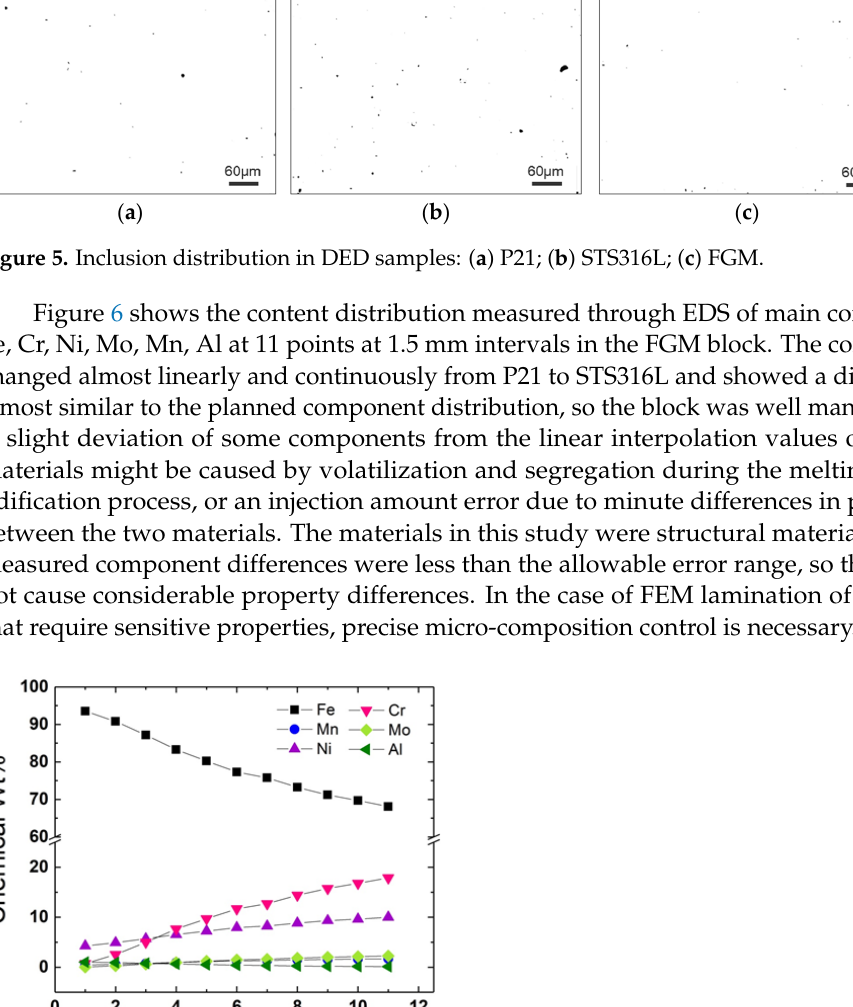
Figure 6. Compositions distributions of FGM block according to location by EDS analysis.